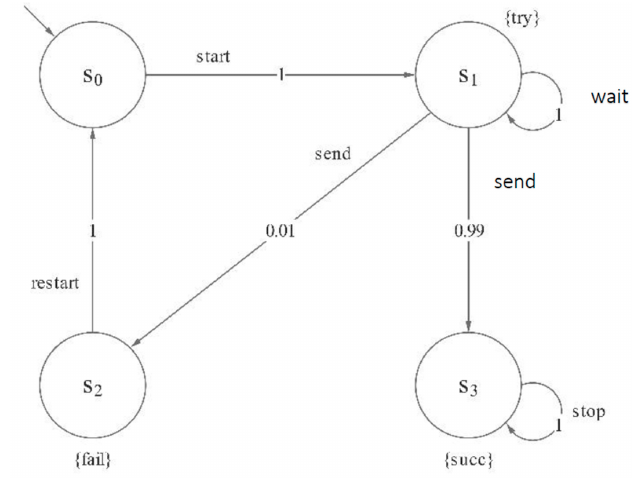
Figure 2. MDP model of a simple communication protocol.